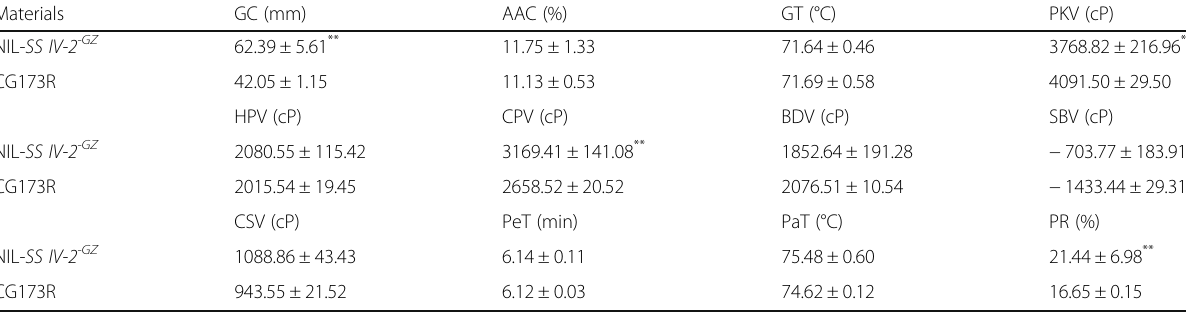
Table 1 Comparison of physicochemical indexes between NIL- SSIV-2 and recurrent parent Materials